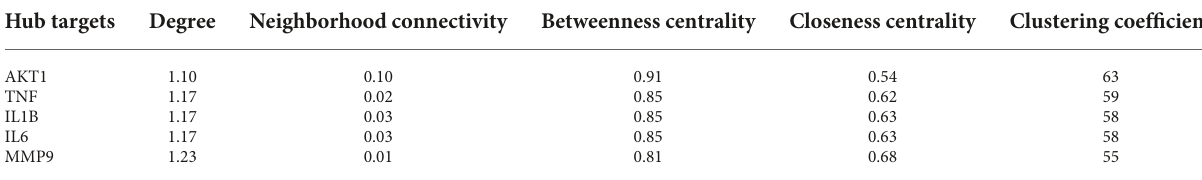
TABLE 3 The topological characteristics of hub